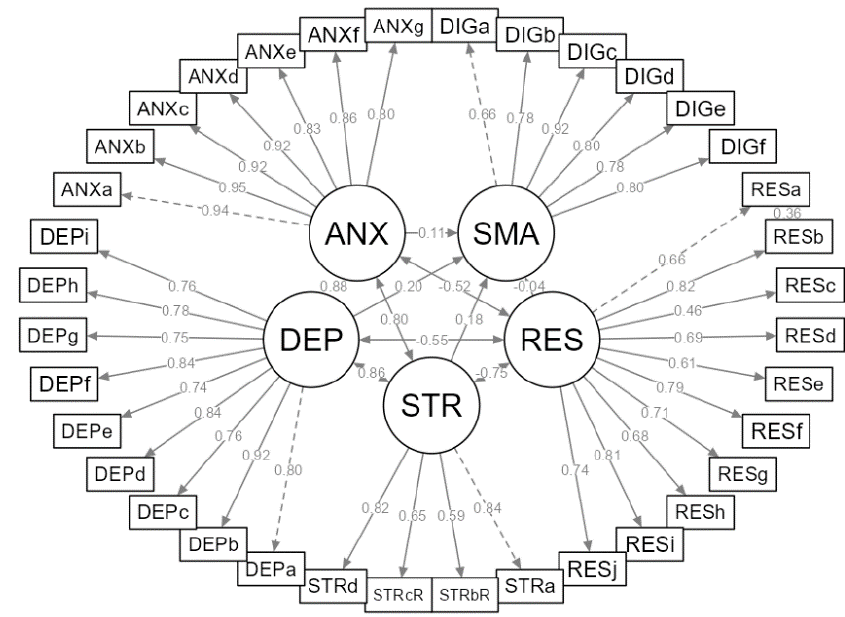
Figure 3. Parameter estimates for the respecified model of social media addiction. Table 8. Total, direct and indirect effects on SMA and their size.